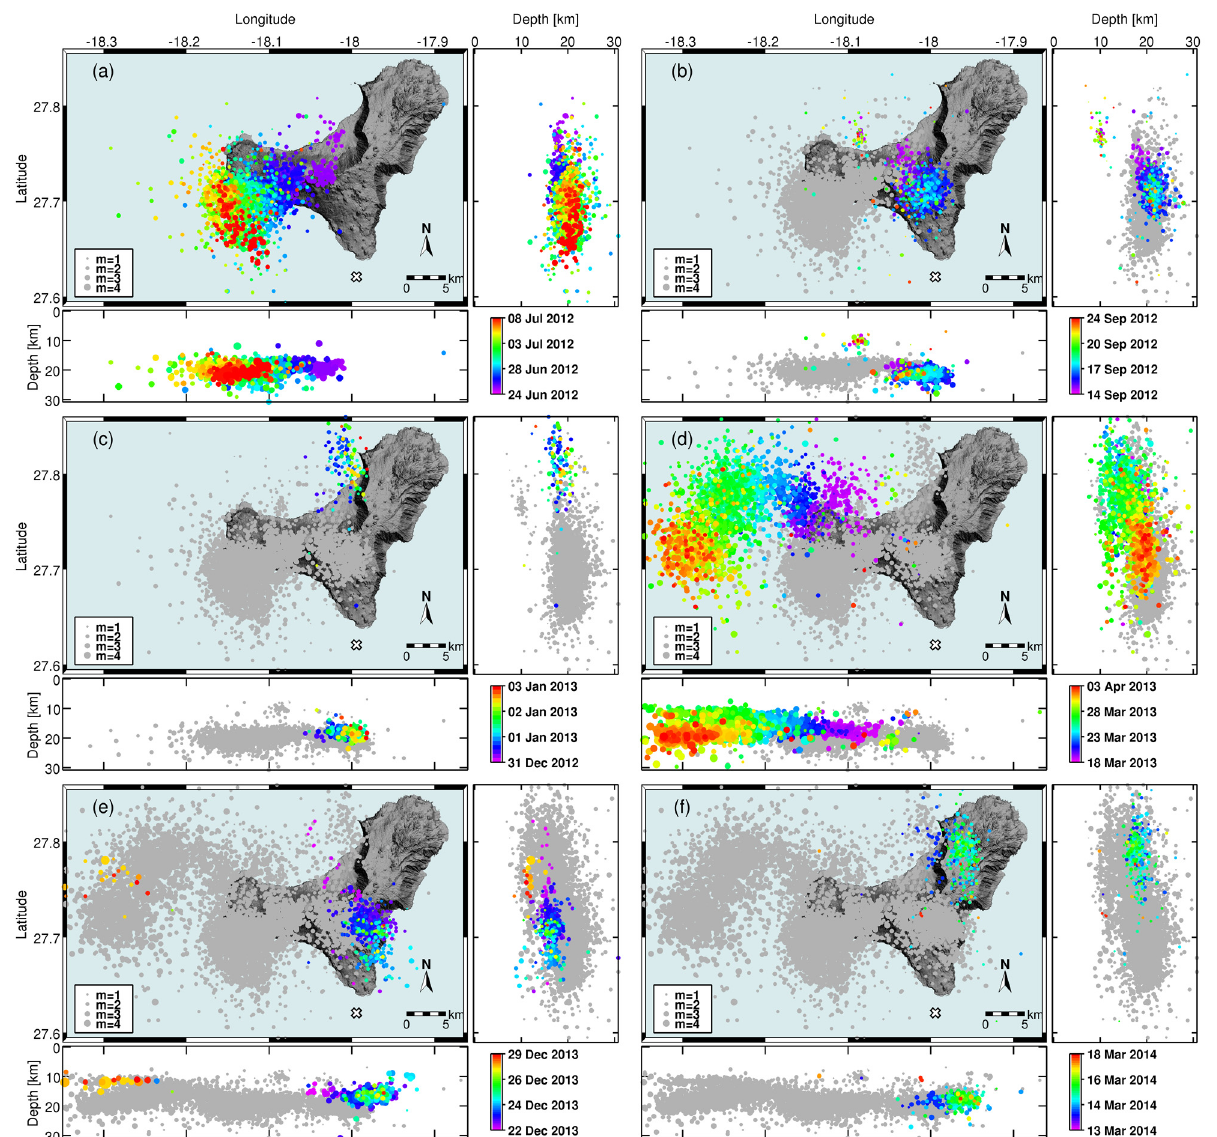
Figure 12. Temporal evolution of the latitude, longitude and depth (km) of the earthquakes for the six distinct seismic episodes occurred after the end of 2011-2012 El Hierro eruption (time scale of events is reported in the color bar; in grey are reported earthquakes occurred in the previous seismic